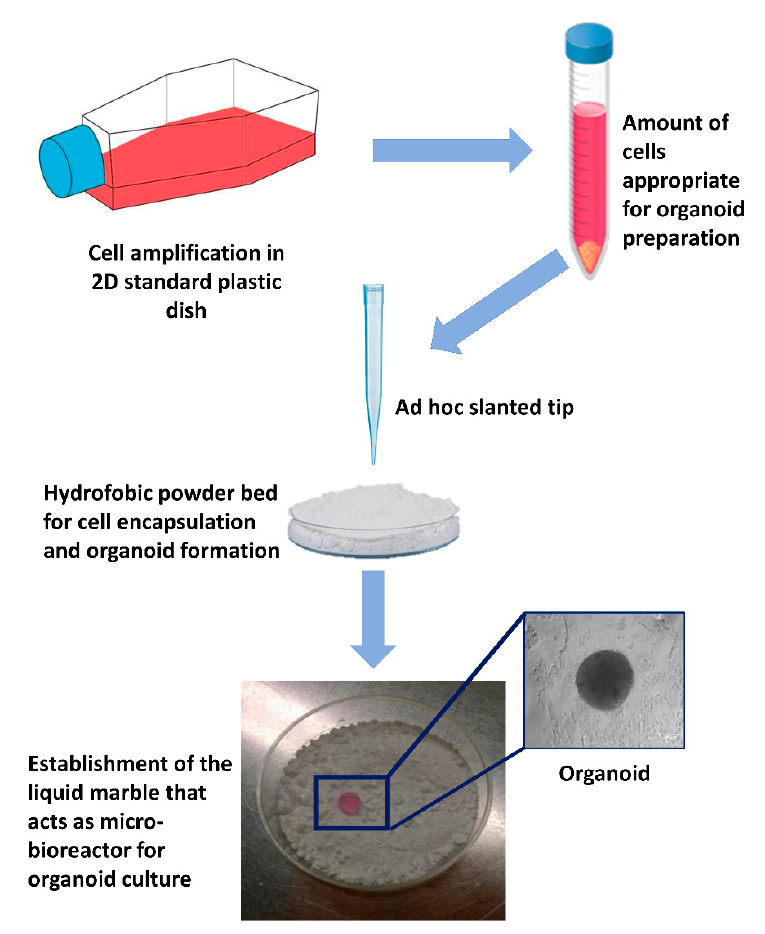
Figure 2. Schematic representation of the protocol used to produce micro-bioreactors and obtain spheroid organoids. 2D cultured cells are detached for the dish and centrifuged. Droplets of medium containing cells are dispensed onto the hydrophobic powder bed. The powder covers the drop, leading to the creation of the liquid marble that allows cell aggregation and organoid for- mation.